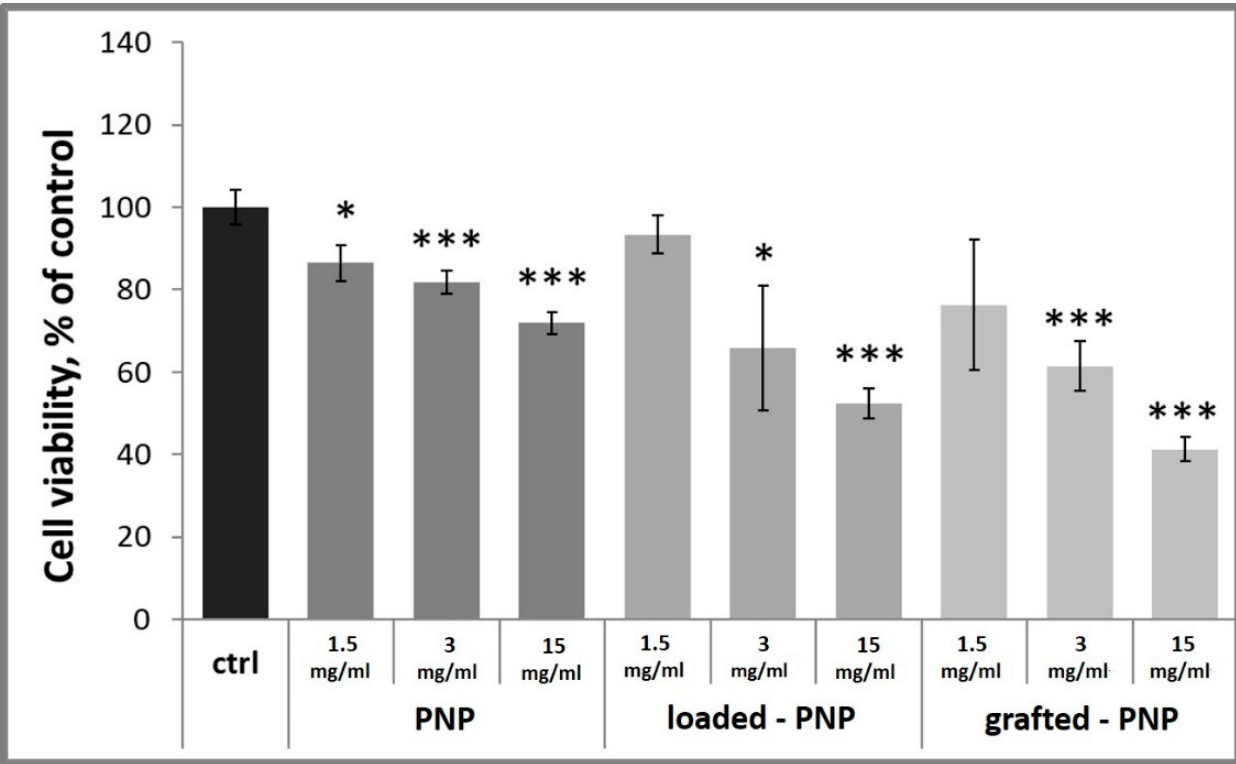
Figure 9. Dose-response experiment on d-PC12 cells. Cells were incubated for 24 h with PNPs. Results are presented as mean ± SD and normalized with respect to the control untreated cells. (* p < 0.05; ** p < 0.01; *** p < 0.001 versus control untreated cells, one-way ANOVA).